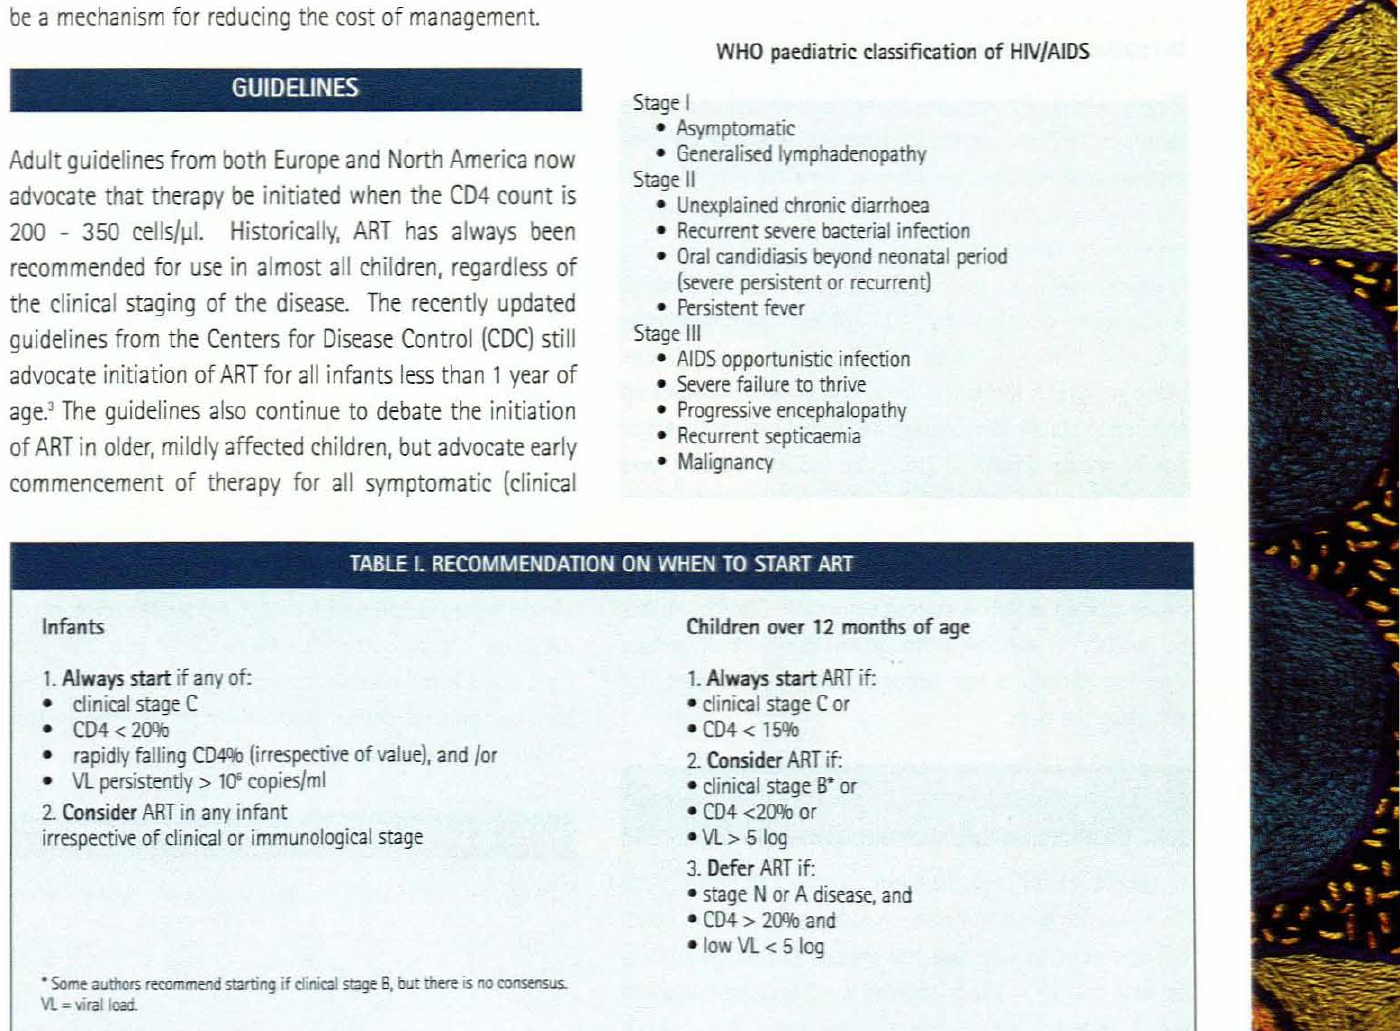
TABLE I. RECOMMENDATION ON WHEN TO START